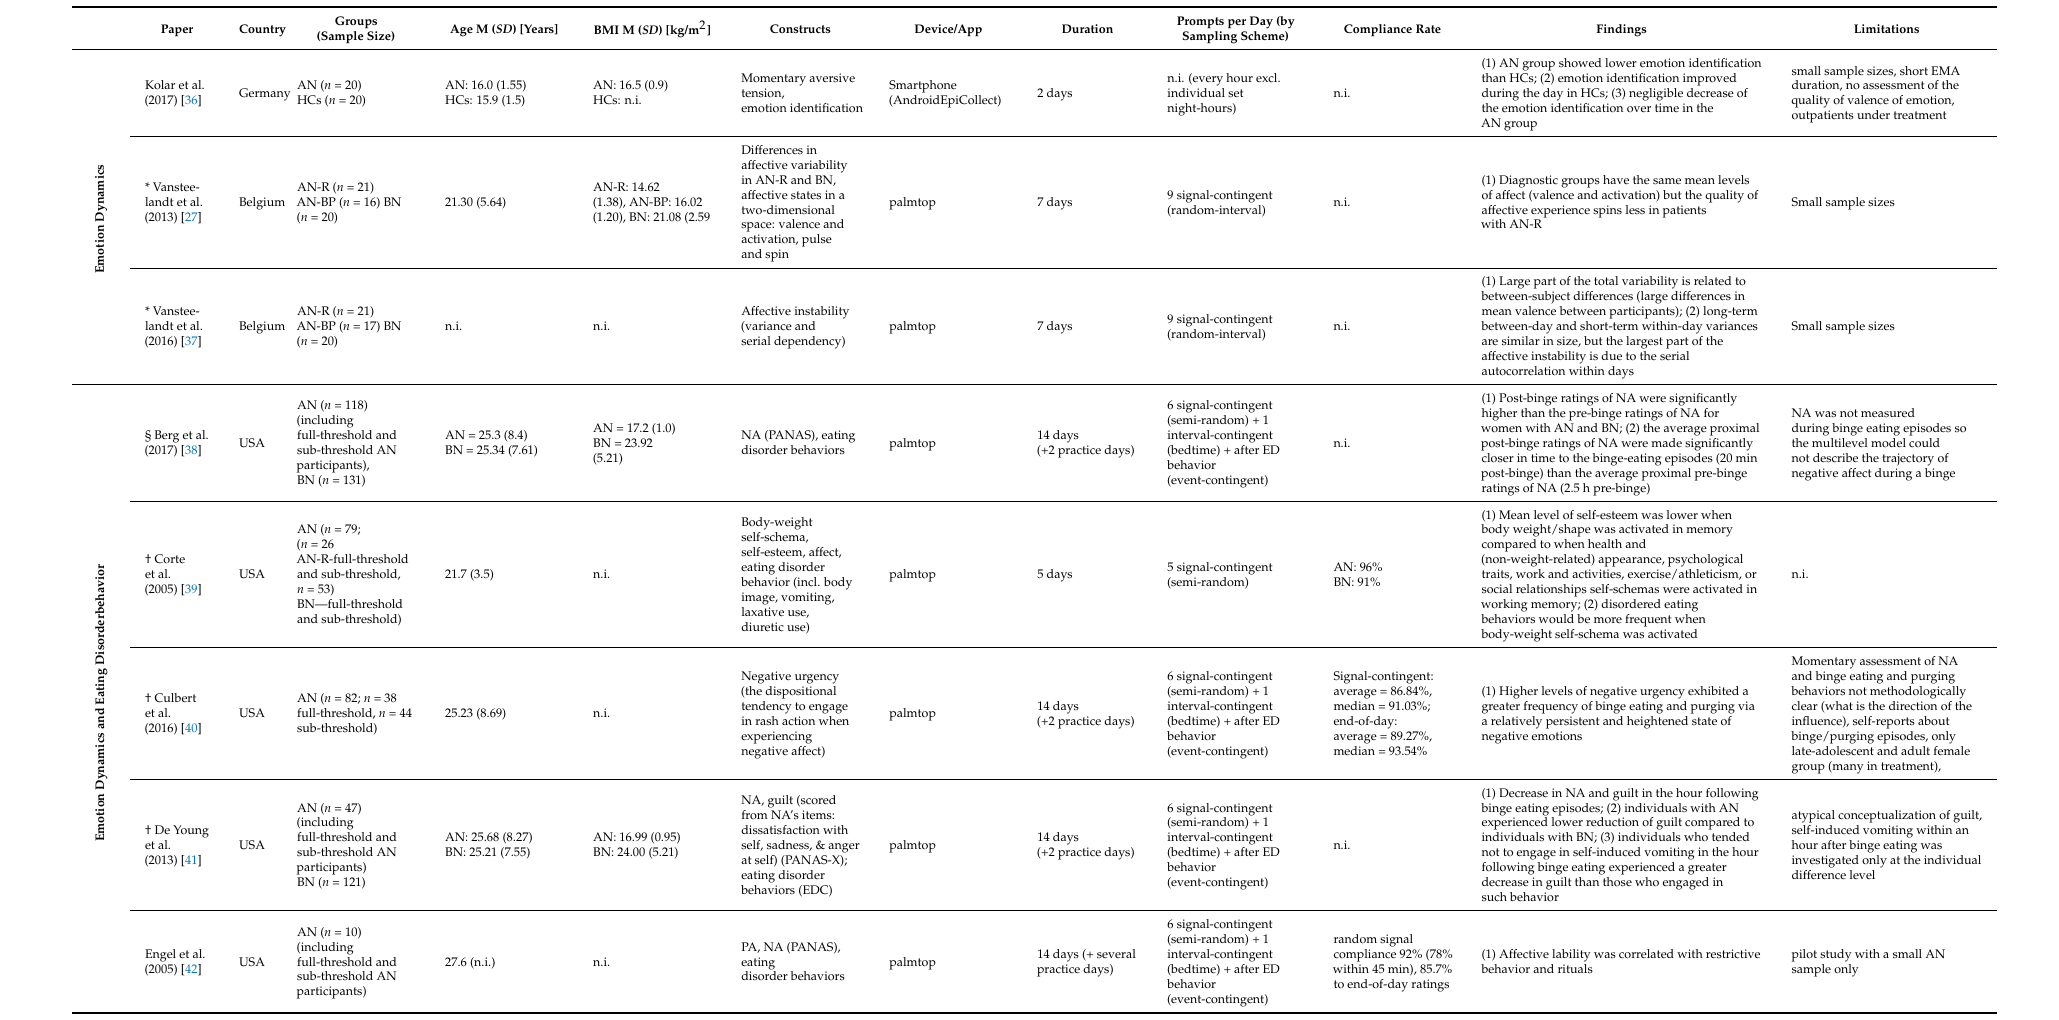
Table 1. Characteristics of the reviewed